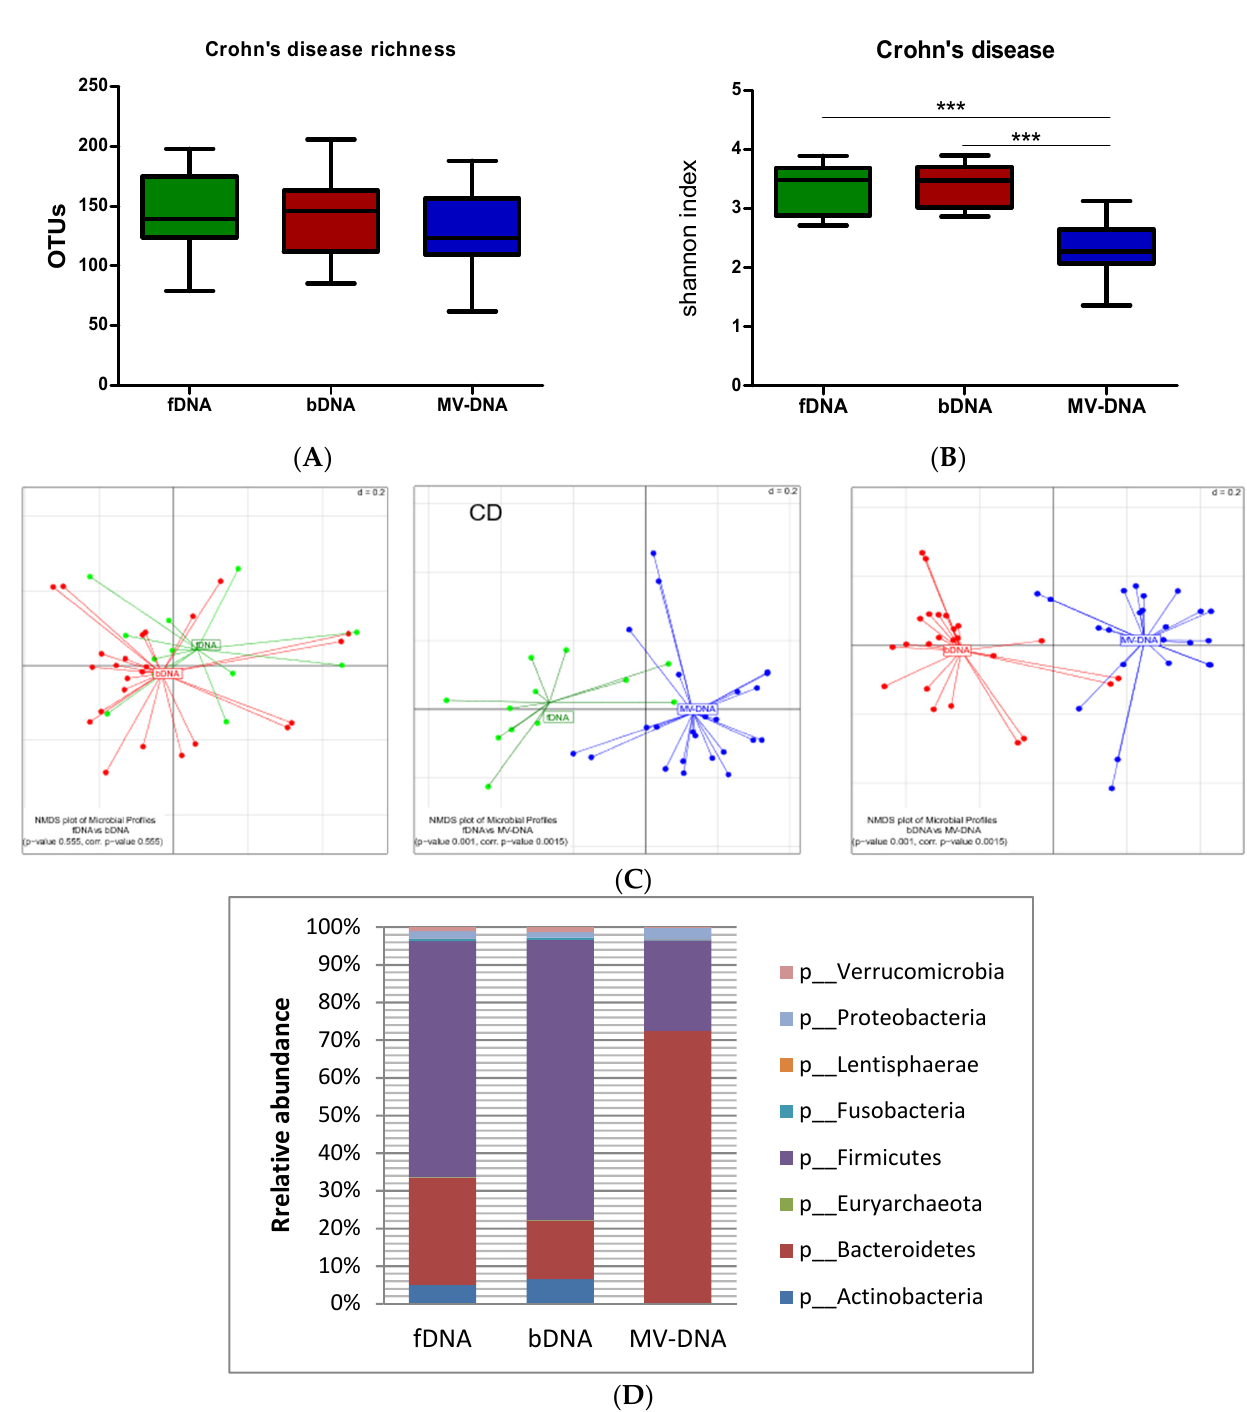
Figure 3. Microbial richness and alpha diversity of DNA obtained from CD to show the differences between the three sample types: OTUs numbers were used to represent the richness of samples. ( A ) Graphs show the richness among the three groups (fDNA, bDNA, and MV-DNA). ( B ) Shannon indices as an indicator for alpha diversity (microbial diversity within the samples). ( C ) Pairwise beta diversity of microbial compositions: non-metric multidimensional scaling (NMDS) calculated from the generalized UniFrac dissimilarity matrix (red: bacterial DNA; green: fecal DNA; blue: vesicles) from the PERMANOVA test used to determine the p -value. ( D ) Relative abundances of the most dominant phyla in CD among the three sample types. Results shown as boxplots with whiskers, and p -value indicated as (*** <